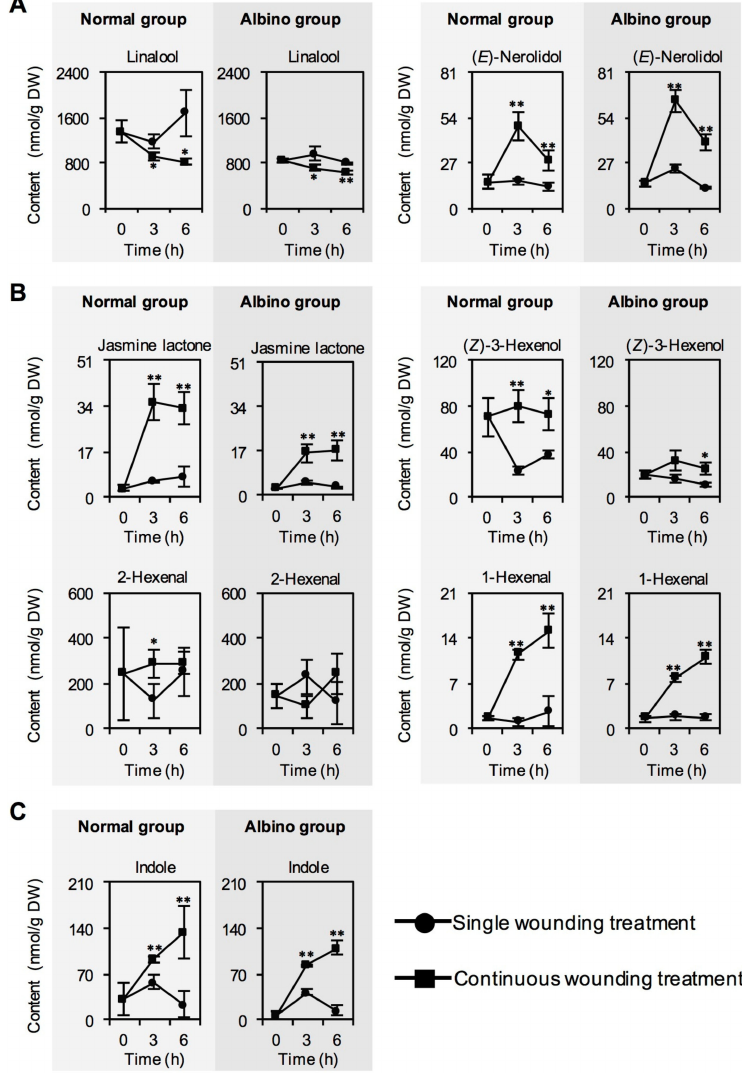
Figure 1. Changes in contents of characteristic aroma compound biosynthetic genes of normal tea leaves and albino tea leaves exposed to single wounding treatment and continuous wounding treatment, respectively. Data are expressed as mean ± SD ( n = 3). * p ≤ 0.05; **, p ≤ 0.01, comparison between single wounding treatment and continuous wounding treatment at the same treatment time. ( A ) Volatile terpenes. ( B ) Volatile fatty acid derivatives. ( C )